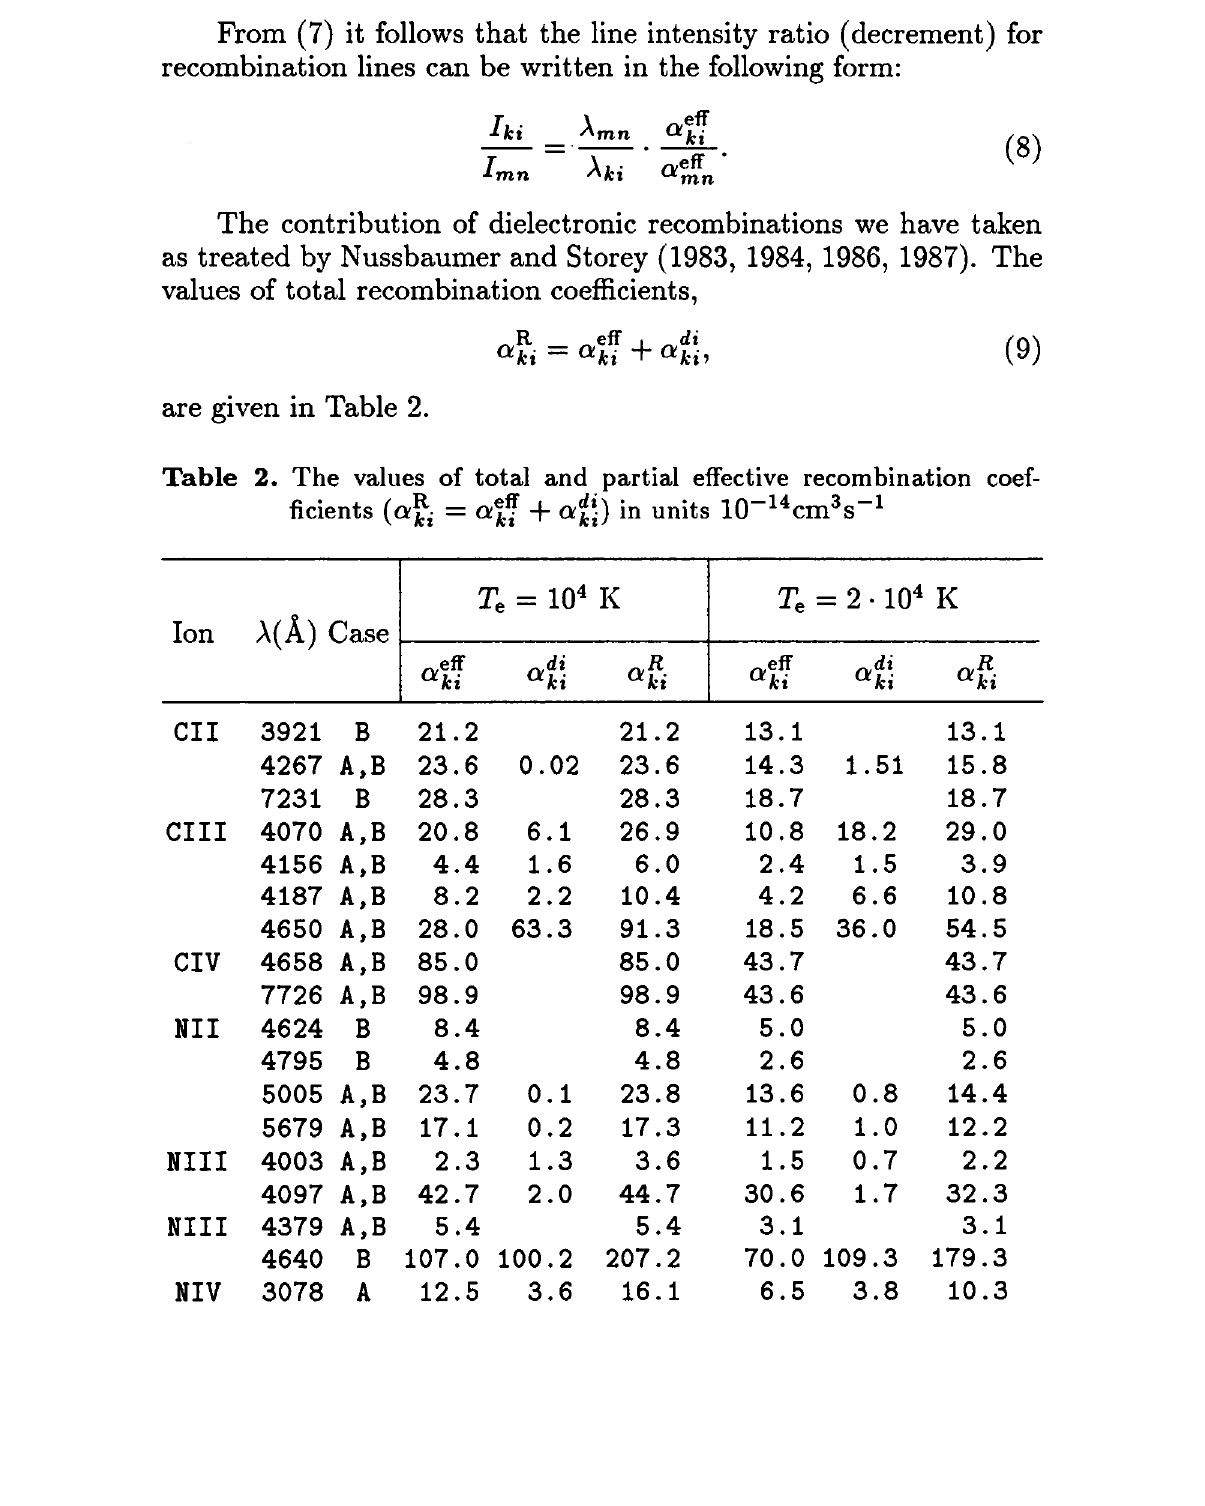
Table 2. The values of total and partial effective recombination coef- ficients (afc = a fi